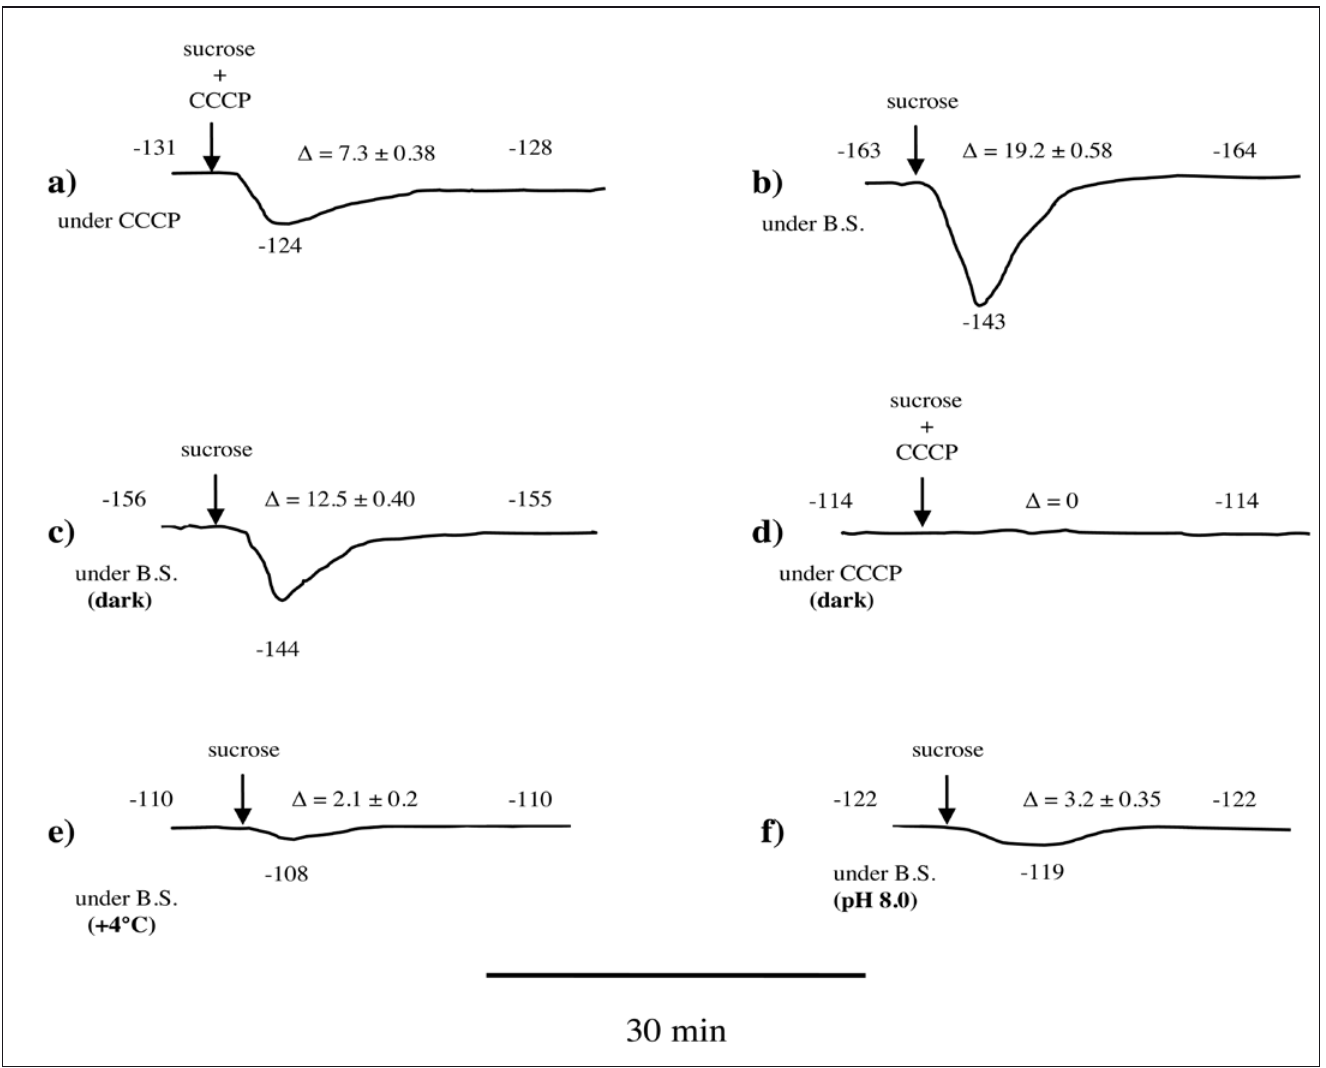
Fig. 3 - Effects of chemical and physical treatments to verify energetic support of sucrose transport. Except where indicated otherwise, measure- ments were carried out in light. Solution at pH 8.0 was buffered with 2 mol m -3 HEPES [N-(2-Hydroxyethyl)piperazine-N’-(2-ethanesulfon- ic acid] -TRIS. Numbers preceded by - are negative mV. Electrophysiological traces are representative of five equivalent measurements. Δ is the depolarization (mV) as the mean of five measurements ±